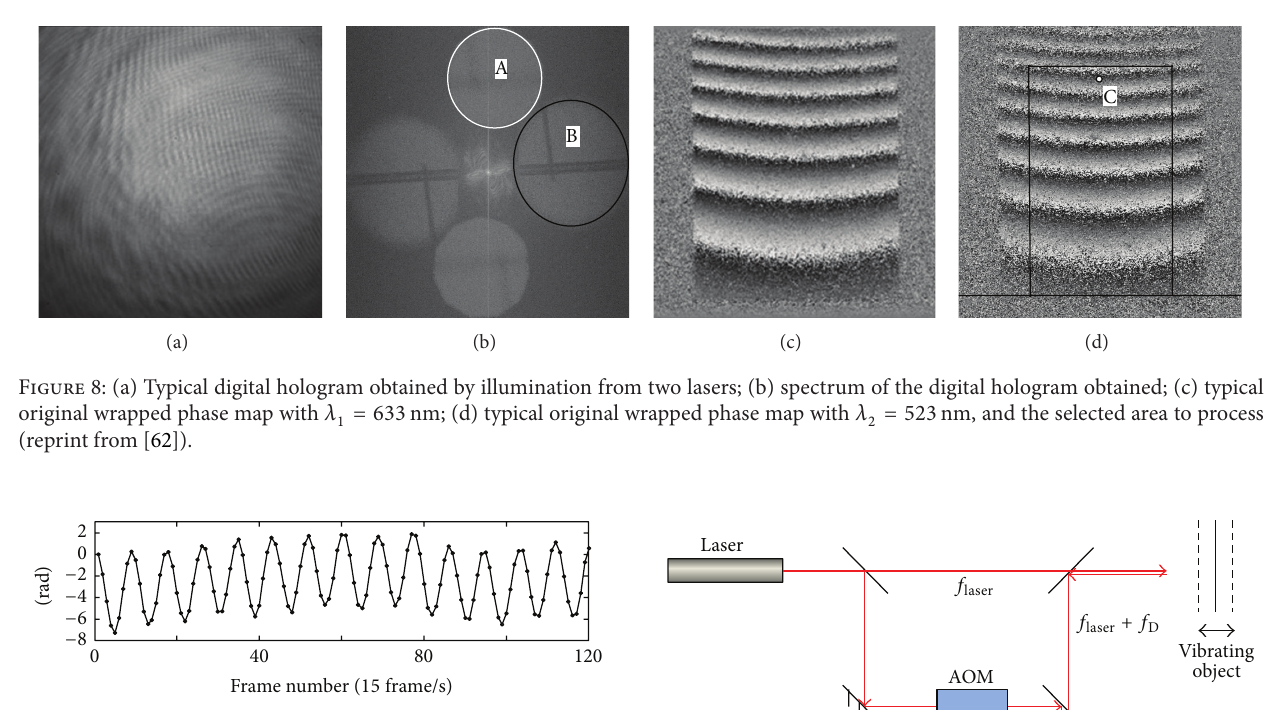
Figure 9: Phase variation of the point C with the synthetic wavelength of 3342 nm which is proportional to the displacement of the object (reprint from [62]).